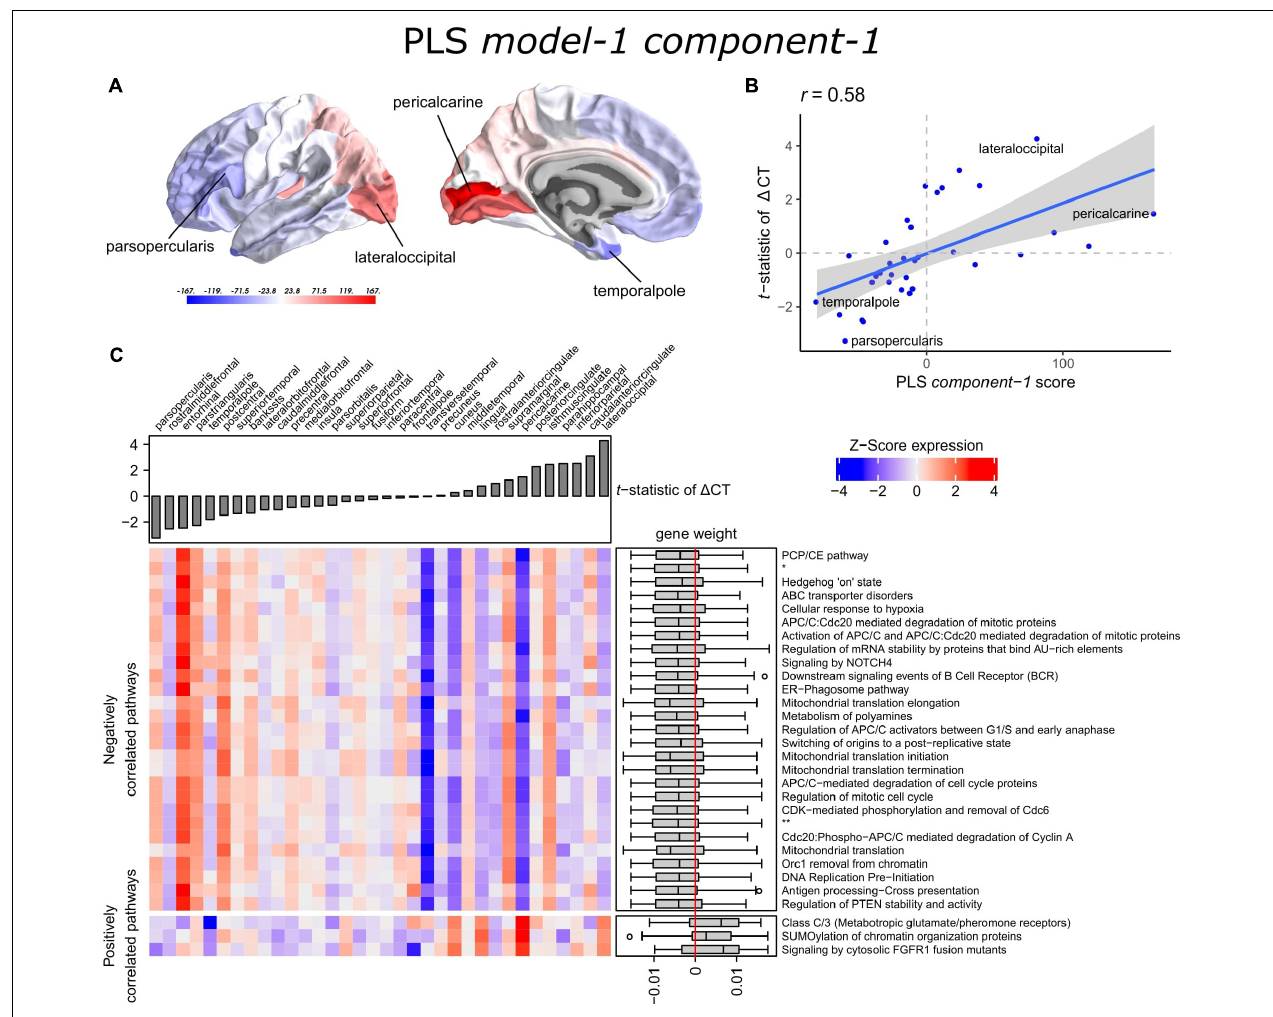
FIGURE 3 | Transcriptional signatures to predict t -statistics of (cid:49) CT between PD patients and controls in PLS model-1 . (A) PLS component-1 scores of predictor variables (gene expression) visualized in cortical regions (lateral and medial view of the left hemisphere). (B) Regression fit of the latent predictor variable, PLS component-1 scores, with the single response variable, CT changes in PD measured as the t -statistics of (cid:49) CT between PD patients (149) and controls (369) across the 34 cortical regions. (C) Mean expression of genes in the top 30 significant pathways (rows) across cortical regions (columns). A complete heatmap with all significant pathways is given in Supplementary Figure 4 . The correlation between transcriptomic signatures and CT changes in PD across cortical regions is predicted by the gene weights for PLS component-1 shown in boxplots for each pathway where the median weight is either negative or positive. Negatively correlated pathways show high gene expression in regions with low t -statistics of (cid:49) CT and gene expression decreases in regions with higher t -statistics of (cid:49) CT. In our analysis, negative t -statistics correspond to increased CT (cortical hypertrophy) and positive t -statistics of (cid:49) CT correspond to decreased CT (cortical atrophy). Positively correlated pathways show low expression in regions with low t -statistics of (cid:49) CT and expression increases in regions with higher t -statistics of (cid:49) CT. * = APC:Cdc20 mediated degradation of cell cycle proteins prior to satisfaction of the cell cycle checkpoint. ** = APC/C:Cdh1 mediated degradation of Cdc20 and other APC/C:Cdh1 targeted proteins in late mitosis/early